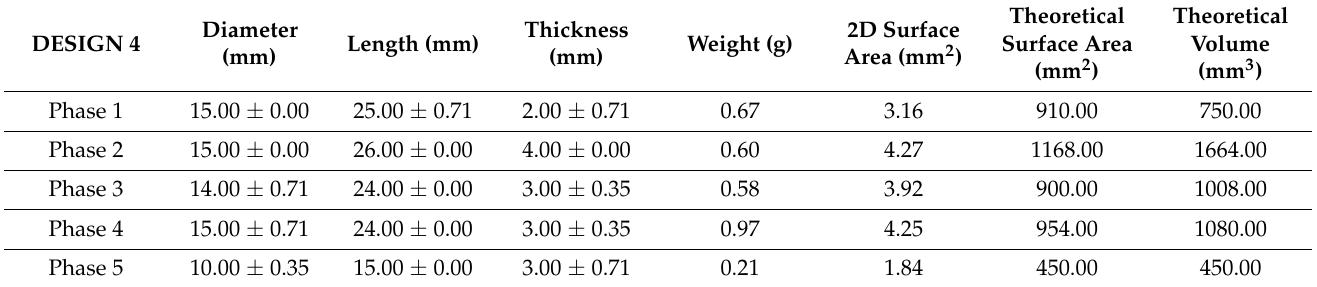
Table 4. Physical properties of 3D-printed gummy bear shape tablet (design 4). Data for diameter, length, and thickness represent the mean ± standard deviation (SD), where n = 2.